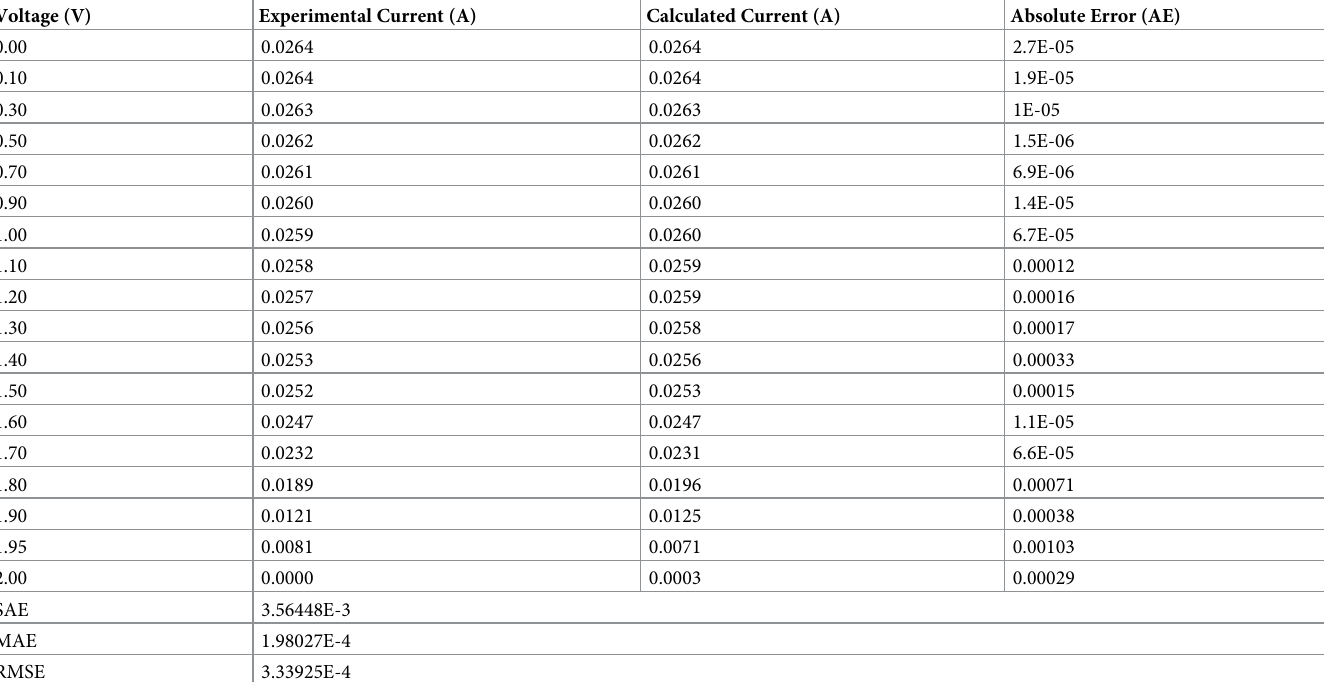
Table 8. ACT simulation-based results for single-diode model of Leybold Solar Module (STE 4/100) at 22˚C under indoor light intensity of 900 W/m 2 . Voltage (V) Experimental Current